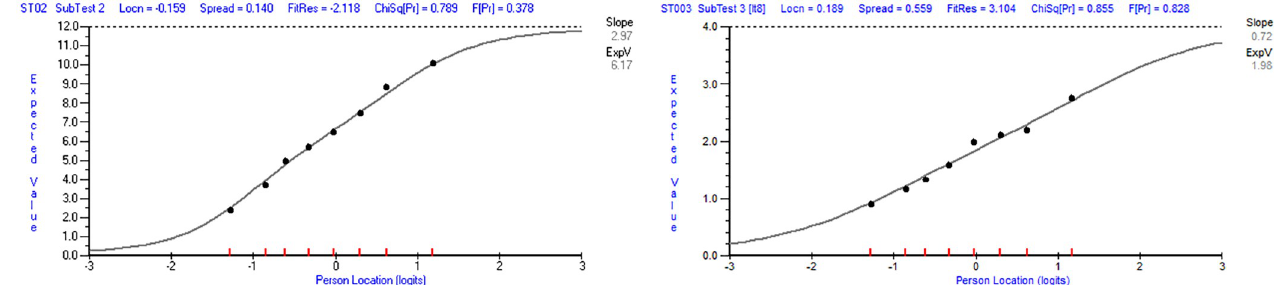
Fig 3. Item characteristic curve for Composite Item 2 (left) and Item 8 (right). Note. The x-axis indicates the latent trait and the y-axis indicates the item score. The black points represent the average observed item responses in each class interval. The grey logistic curve indicates the expected item responses. The slope of the Item Characteristic Curve indicates the rate of change of the expected value with respect to the latent trait at the mid-point between the minimum and maximum